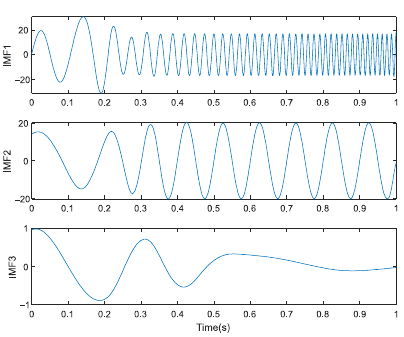
Figure 5. EMD decomposition.